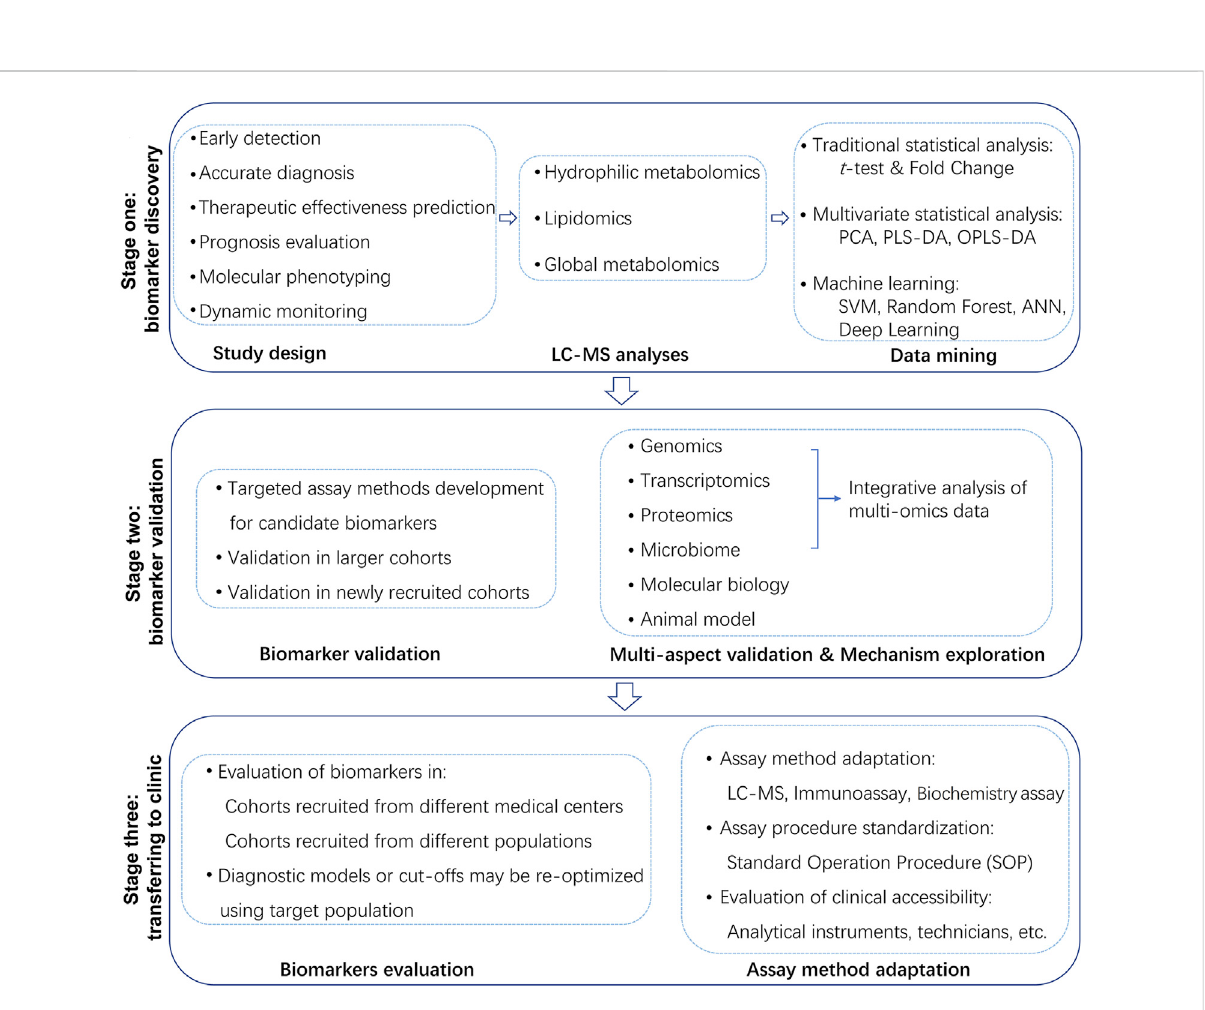
FIGURE 1 Flowchart of the typical steps of precision medicine-oriented metabolomic